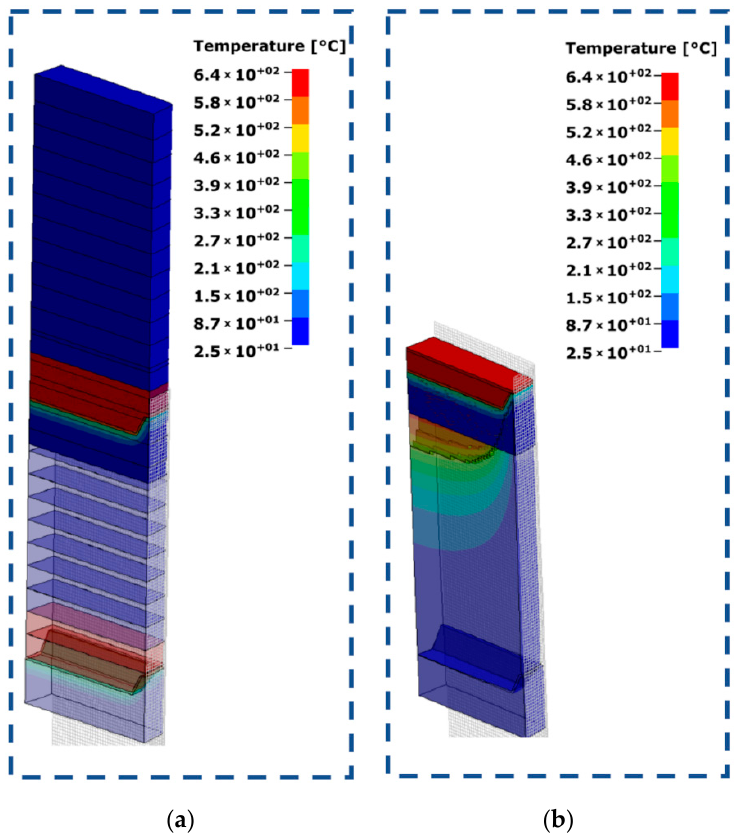
Figure 4. Comparison between mesh insertion strategies for; ( a ) BT; and ( b ) DMT for 1.4 m billet length.